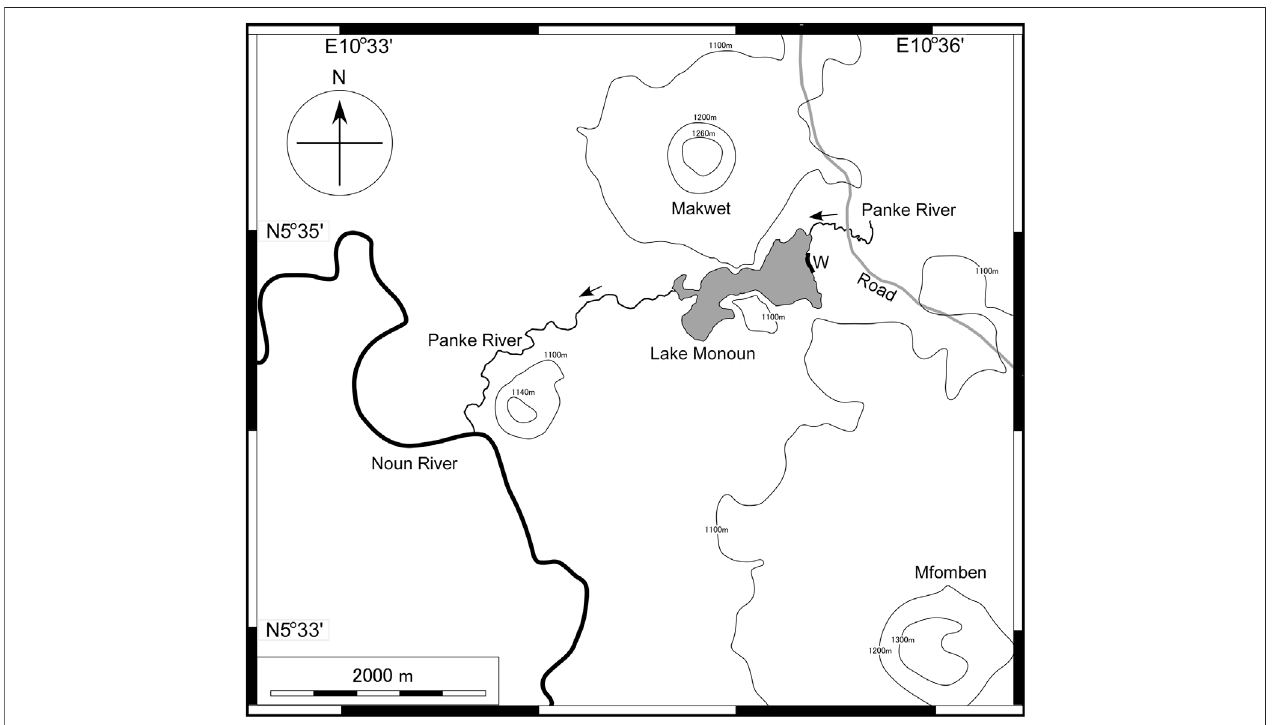
FIGURE1| LocationofLakeMonouninCameroon.Theshadedregionindicateslakewater.Arrowsindicatethedirectionofriver fl ow.Wistheareaaffectedbythe waves generated during the limnic eruption in 1984 (Sigurdsson et al., 1987).